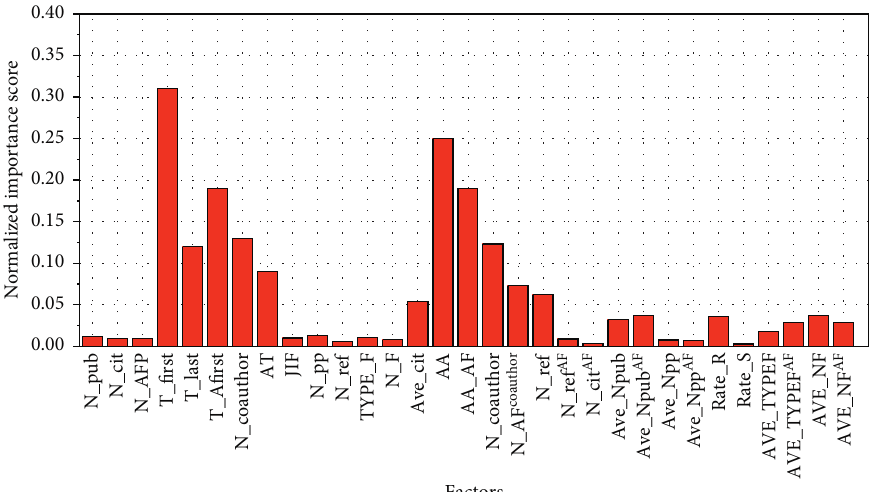
Figure 3: Intuitive factors’ importance rankings.